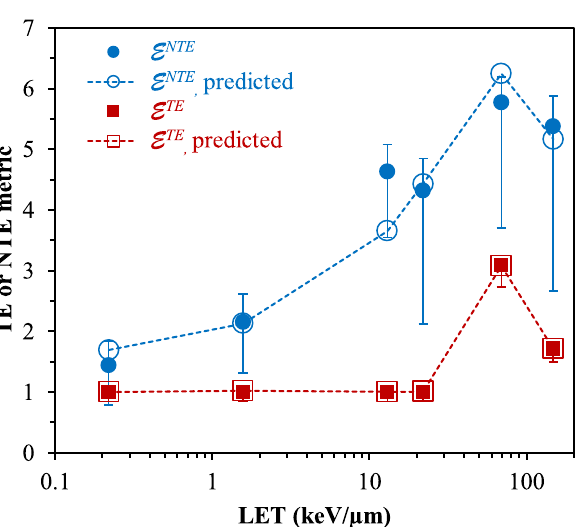
TE NTE Figure 3. TE and NTE metrics, E and E for the 6 radiation types. These metrics were derived from fitting the dose–response model to the measured data. Corresponding predictions were produced based on d ( y ) and best-fit q ɛ ( y ) functions, as explained in the text. Error bars represent 95% CIs. Predictions are shown for the spherical target diameter of 16 µm, and they were similar for the other investigated diameters. Straight lines connecting the points are shown only to guide the